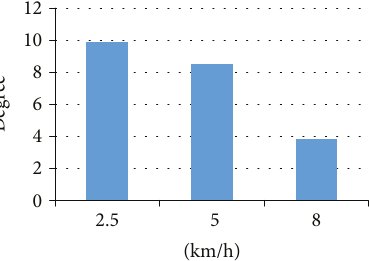
Figure 9: The maximum tilting angle at di ff erent velocities before fractures